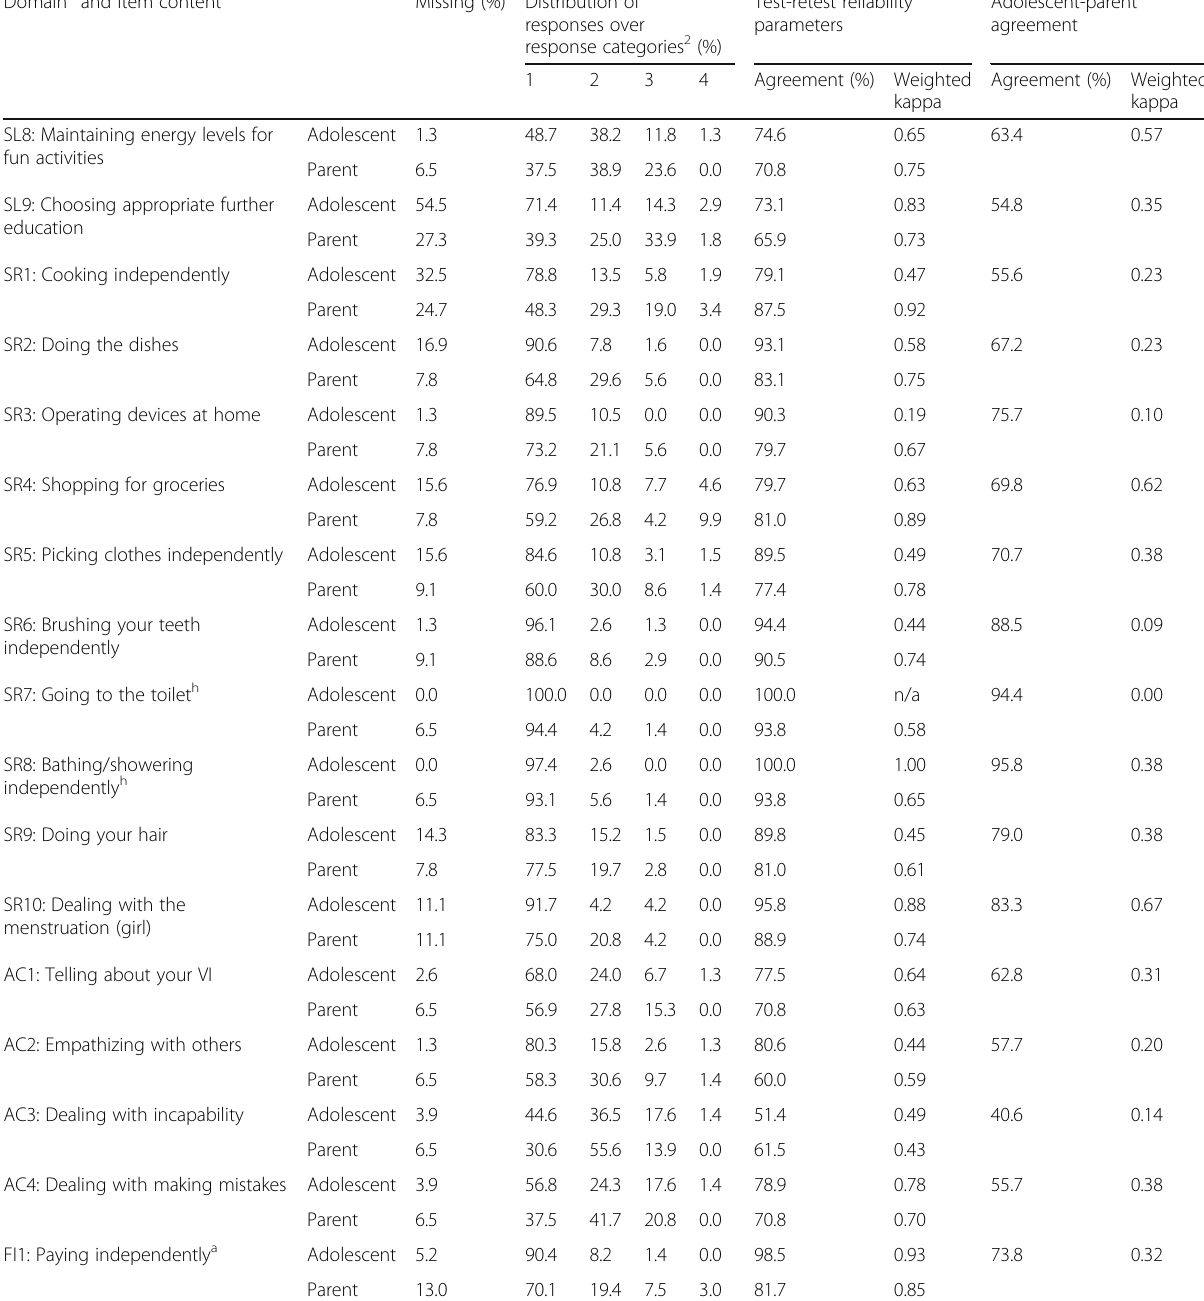
Table 2 Distribution of responses and parameters of test-retest reliability and adolescent-parent agreement (Continued) Domain 1 and item